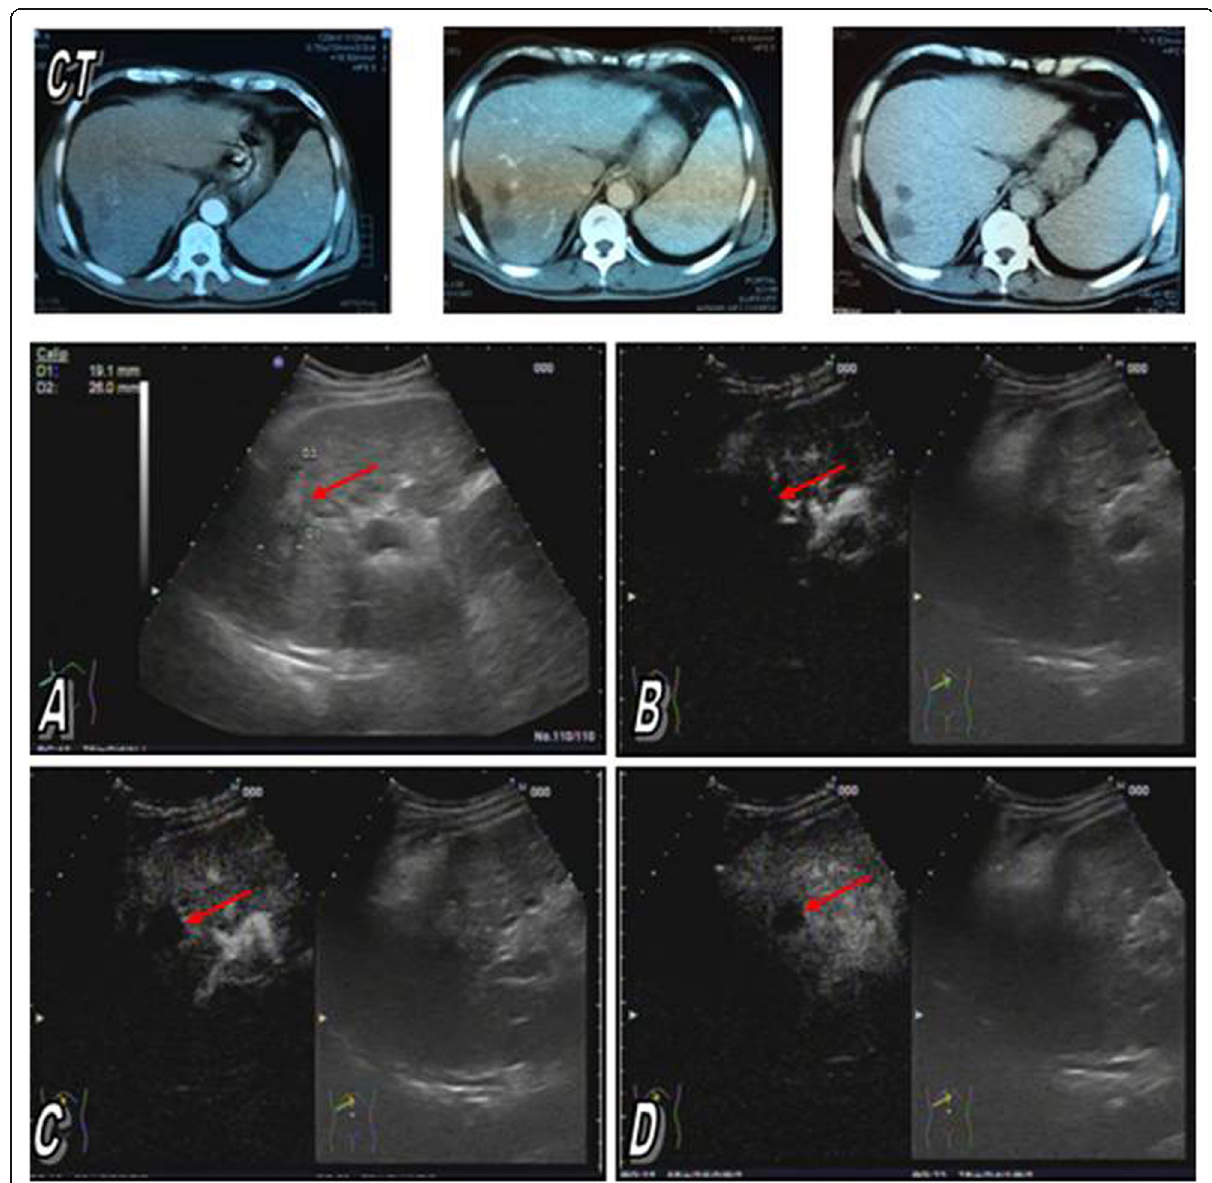
Fig. 3 A 62-year-old male, HCV + ve, AFP serum level (4 ng/ml), referred for follow-up post-radiofrequency ablation. Triphasic CT study revealed persistent non-enhancing hypodense ablation zone within right hepatic lobe. a NEUS revealed two adjacent hyperechoic lesions measuring about 2.6 cm and 1.9 cm. b – d CEUS real-time examination during early arterial phase, portal phase, and late phase showed persistent non- enhancement of the lesions, consistent with well-ablated